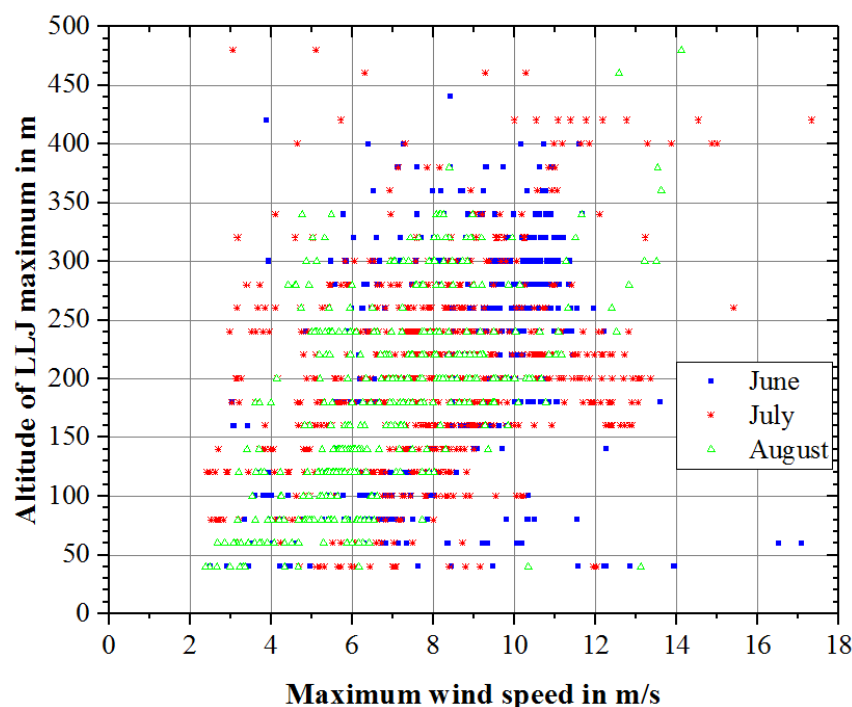
Figure 4. Relationship of maximum wind speed and altitude of maximum wind speed for LLJ events identified by the 2ms − 1 criteria during the months June 2013 (blue), July 2013 (red) and August 2013